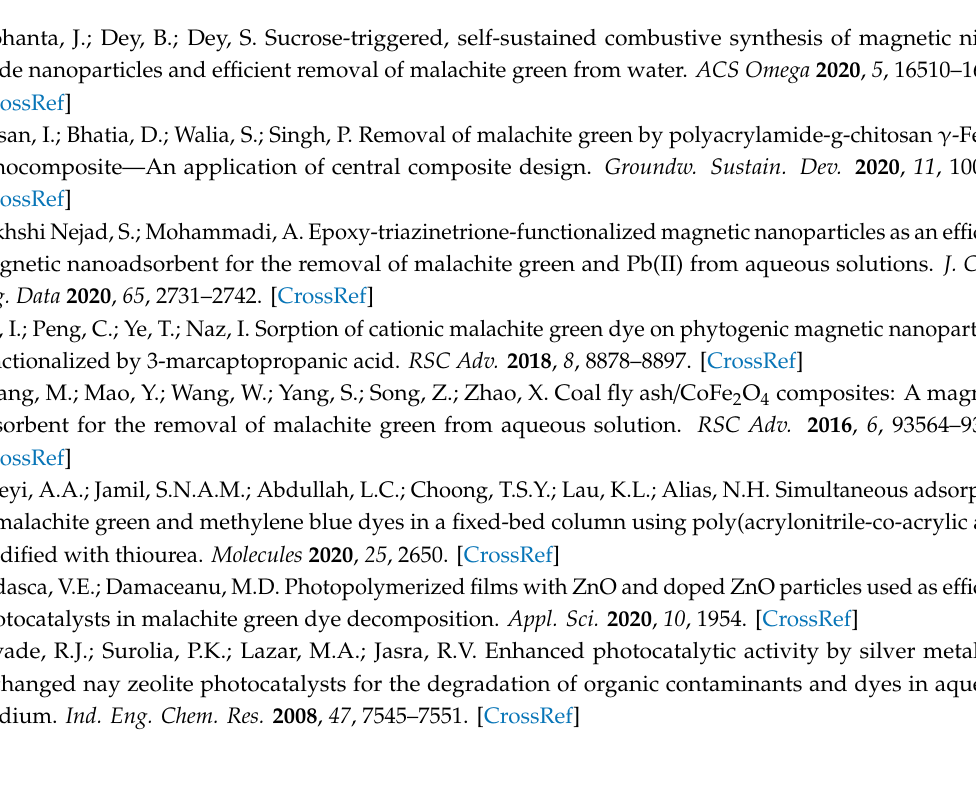
Figure S1: UV-Vis Spectra with time profile to observe the growth of NiFe 2 O 4 spinel nuclei under the influence of CT-AS biopolymer blend, Figure S2: XRD spectra CTAS@NIFE nanocomposite, Figure S3: TEM image of CTAS@NIFE bio nanocomposite at 50 nm magnification, Table S1: Concentration vs. percent degradation data with standard deviation for MG degradation using 20 mg catalyst under 6.35 W · mL − 1 ultrasonic power, Table S2: Ce / Co values with standard deviation with respect to variable pH conditions for MG degradation using 20 mg catalyst under 6.35 W · mL − 1 ultrasonic power, Table S3: Ce / Co values with standard deviation with respect to variable pH conditions for MG degradation using 20 mg catalyst under 6.35 W · mL − 1 ultrasonic power, Table S4: Ultrasonic power vs. % MG degradation with standard deviation data for MG degradation using 20 mg catalyst at 90 min of irradiation, pH 8 for 35, 55 and 70 mg · L − 1 MG concentration, Table S5: -Ln (Ce / Co) values with standard deviation with respect to irradiation time for pseudo first order kinetics for 35, 55 and 70 mg · L − 1 MG concentration using 20 mg catalyst at pH 8 and 6.35 W · mL − 1 ultrasonic power, Table S6: 1 / Ce values with standard deviation with respect to irradiation time for pseudo second order kinetics for 35, 55 and 70 mg · L − 1 MG concentration using 20 mg catalyst at pH 8 and 6.35 W · mL − 1 ultrasonic